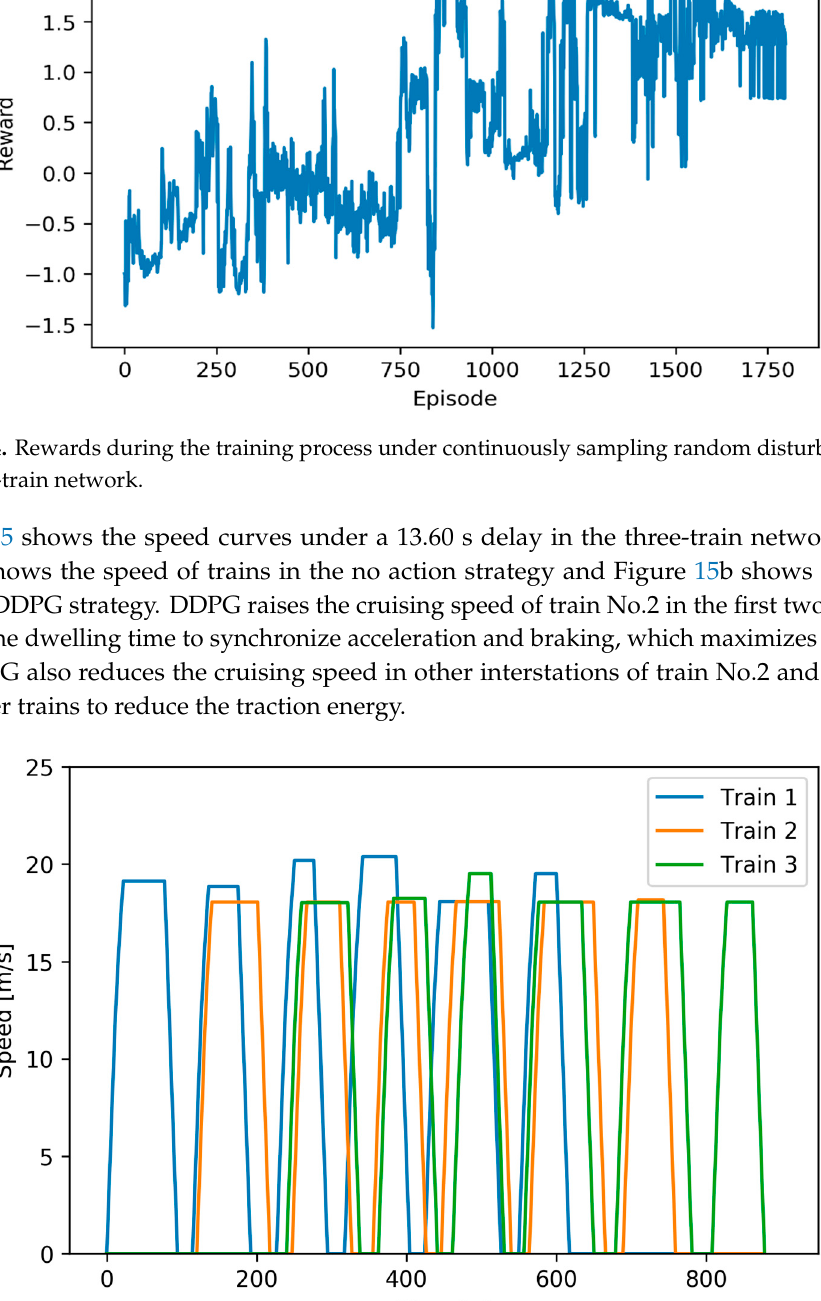
Table 7. Energy consumption and average spending time during the testing process under